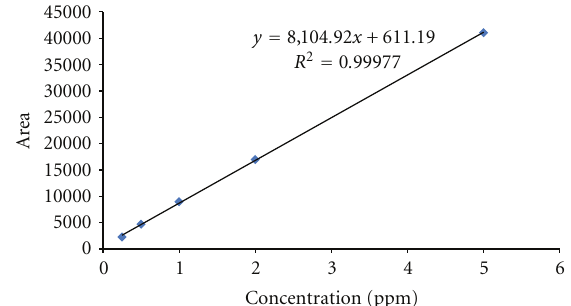
Figure 2: Result of calibration slope using CH 4 standard gas.